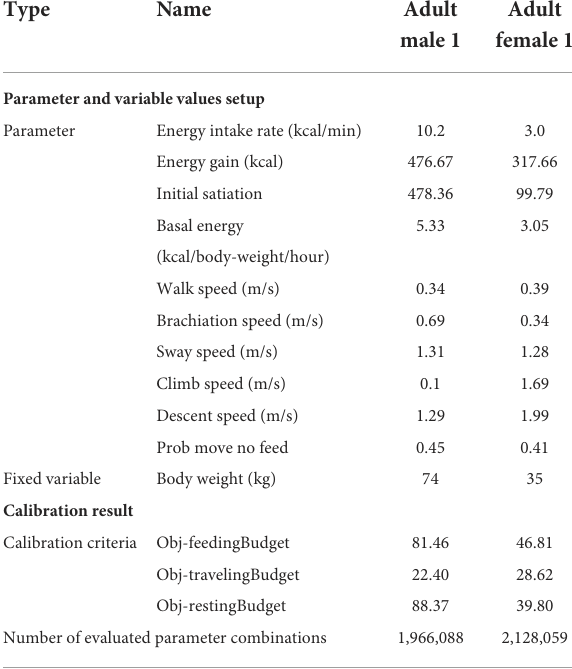
TABLE 3 The parameter set and fixed variables that have led to the solution selected in Figure 6 for an adult male and adult